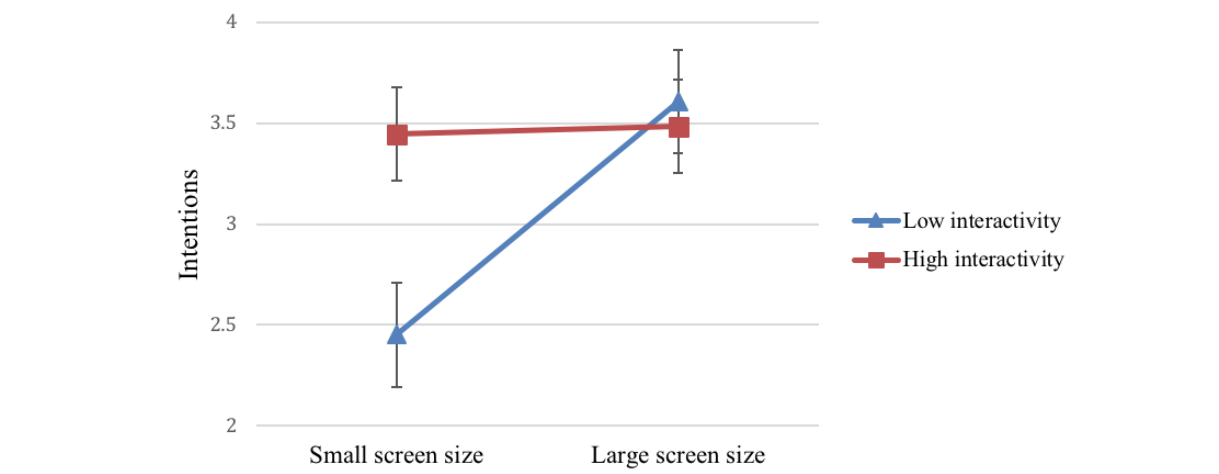
Figure 4. Two-way interaction of screen size and interactivity on intentions.